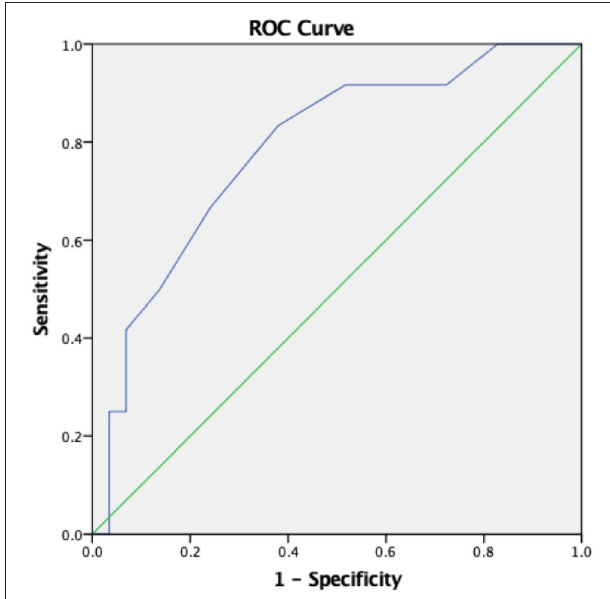
FIGURE 4 | ROC curve using ROI 4 (base) to distinguish DVI patients (AUC 0.806).